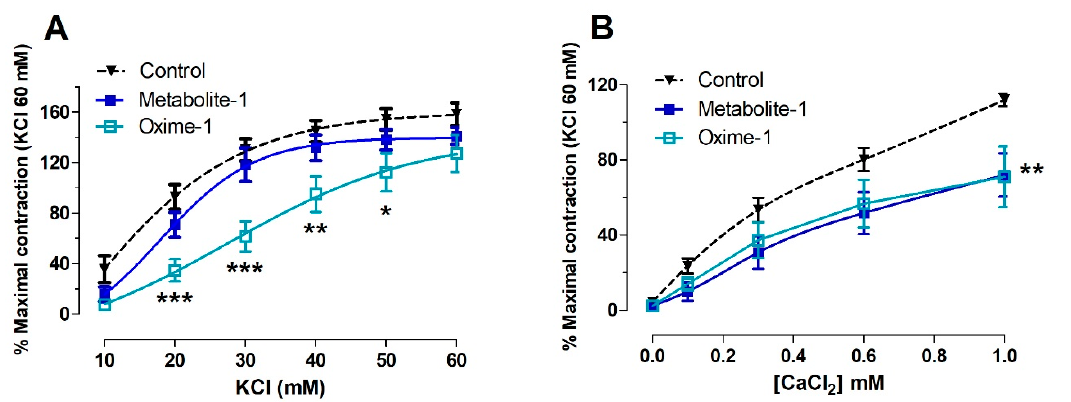
Figure 6. Effect of metabolite–1 and oxime–1 on the contractile response to KCl in rat aorta. The contraction to KCl was compared to contraction with KCl 60 mM obtained at the beginning of the experiment, during the equilibration period of tissues. Intact aortic rings were pre-incubated with 10 − 5 M metabolite–1 or oxime–1 for 20 min. Subsequently, aortic rings were contracted with cumulative concentrations of KCl (10 to 60 mM) ( A ). On the other hand, the aortic rings were pre-incubated in a free Ca 2+ buffer for 10 min before 40 mM KCl was added, and then, the CaCl 2 (0.1 to 1 mM) was added to the bath ( B ). Data are presented as the average standard error of the mean (SEM) of 4 independent experiments. * p < 0.05; ** p < 0.01; *** p < 0.001 versus the curve in the absence of bioactive molecules (Control). Table 4. Effect of metabolite–1 or oxime–1 on contractile response to KCl (10 to 60 mM) in intact aortic rings incubated under different Ca 2+ concentrations in the external medium.